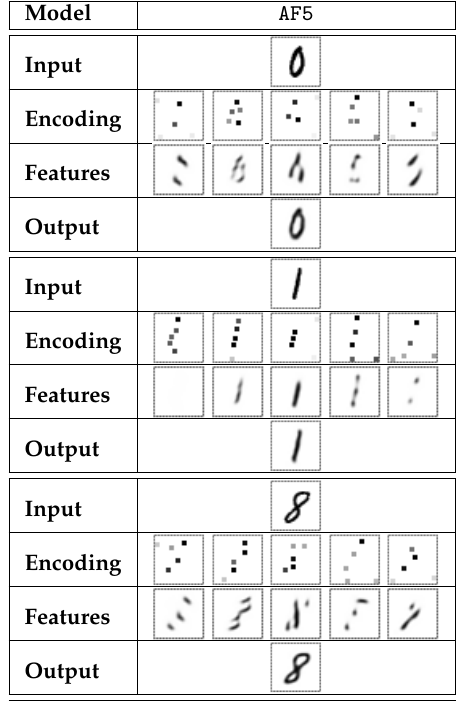
Figure 10. Sample encoding of selected digits performed by AF5 model. Highly sparse encoding (up to 5 non-zero elements in each encoding matrix) was used. Feature-specific decodings are presented, similar to those in Figure